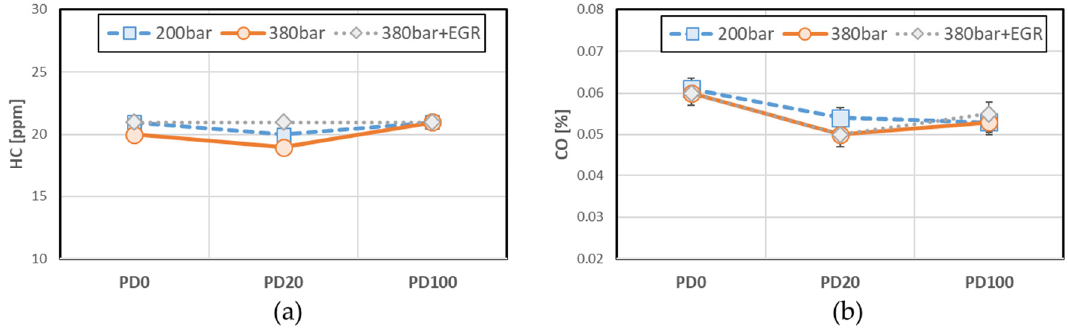
Figure 9. CO ( a ) and HC ( b ).